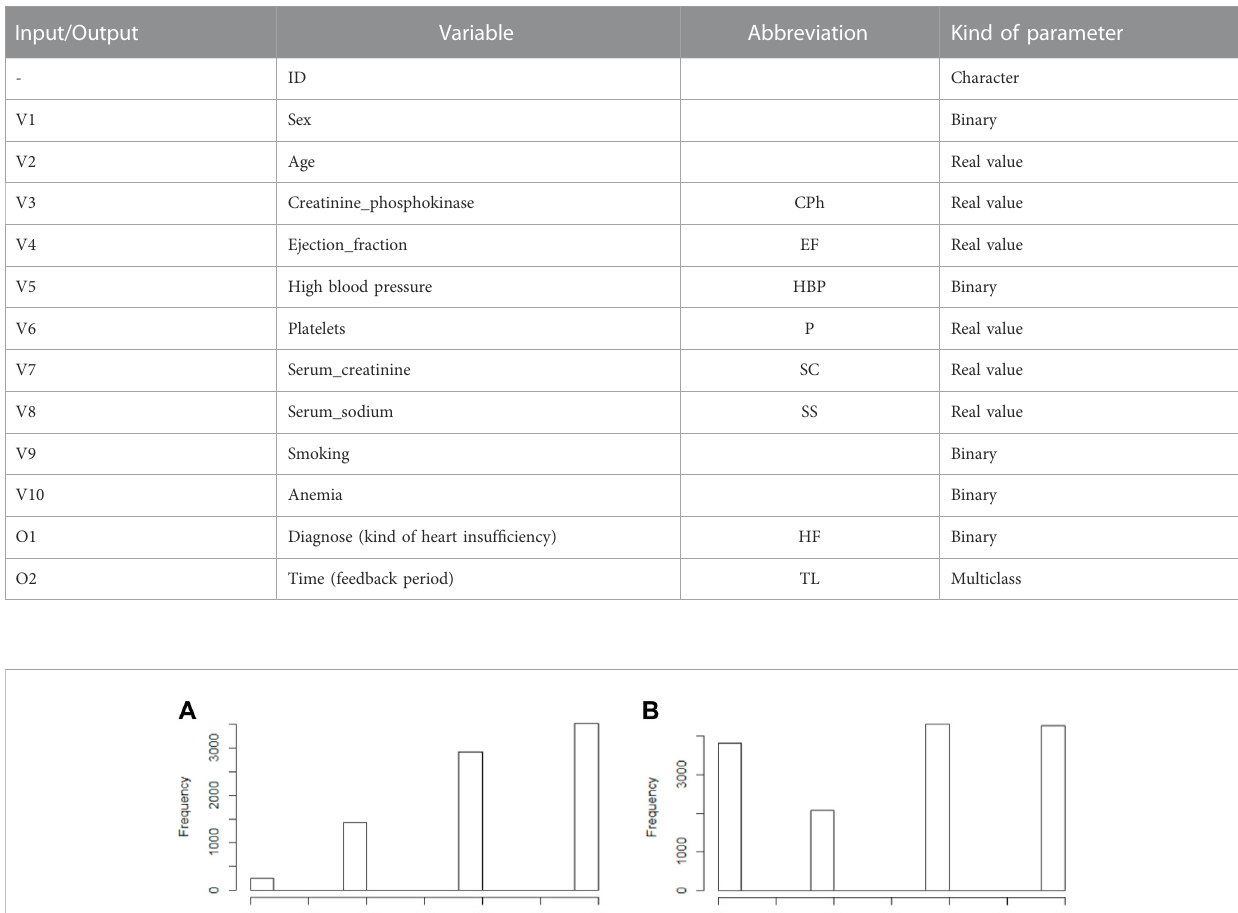
TABLE 1 Principal input and output parameters extracted from the HER of diabetic patients with heart insuf fi ciency. Input/Output